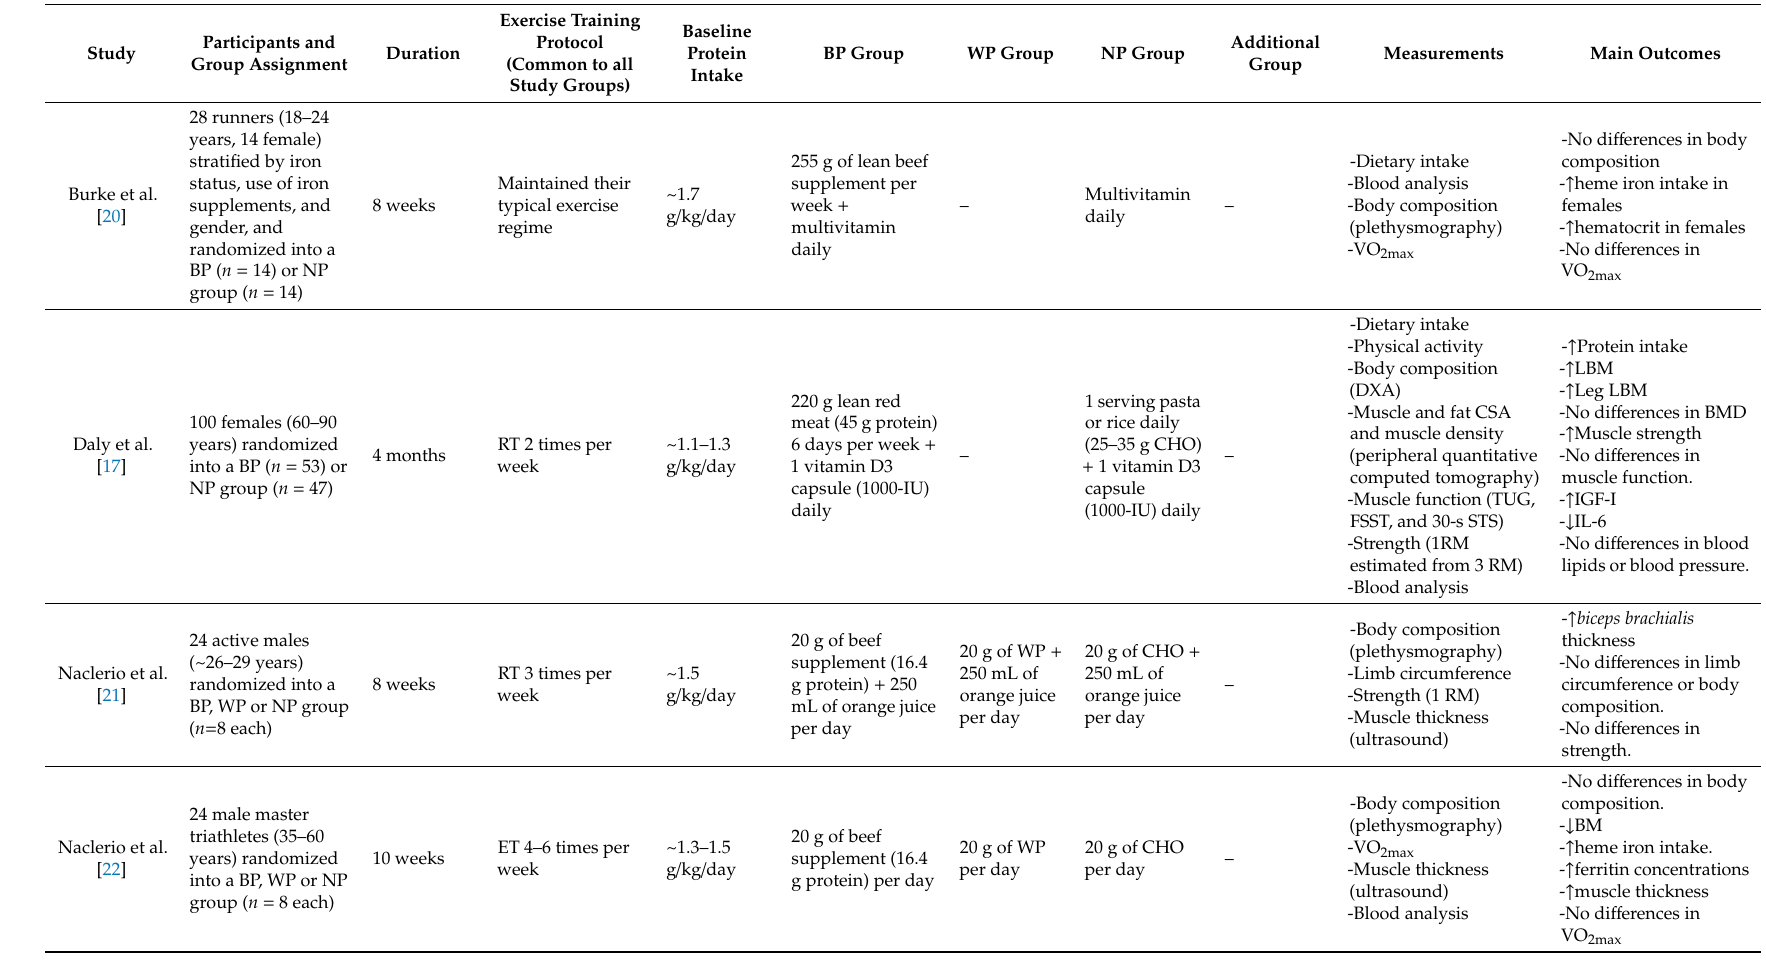
Table 1. Main characteristics of the included